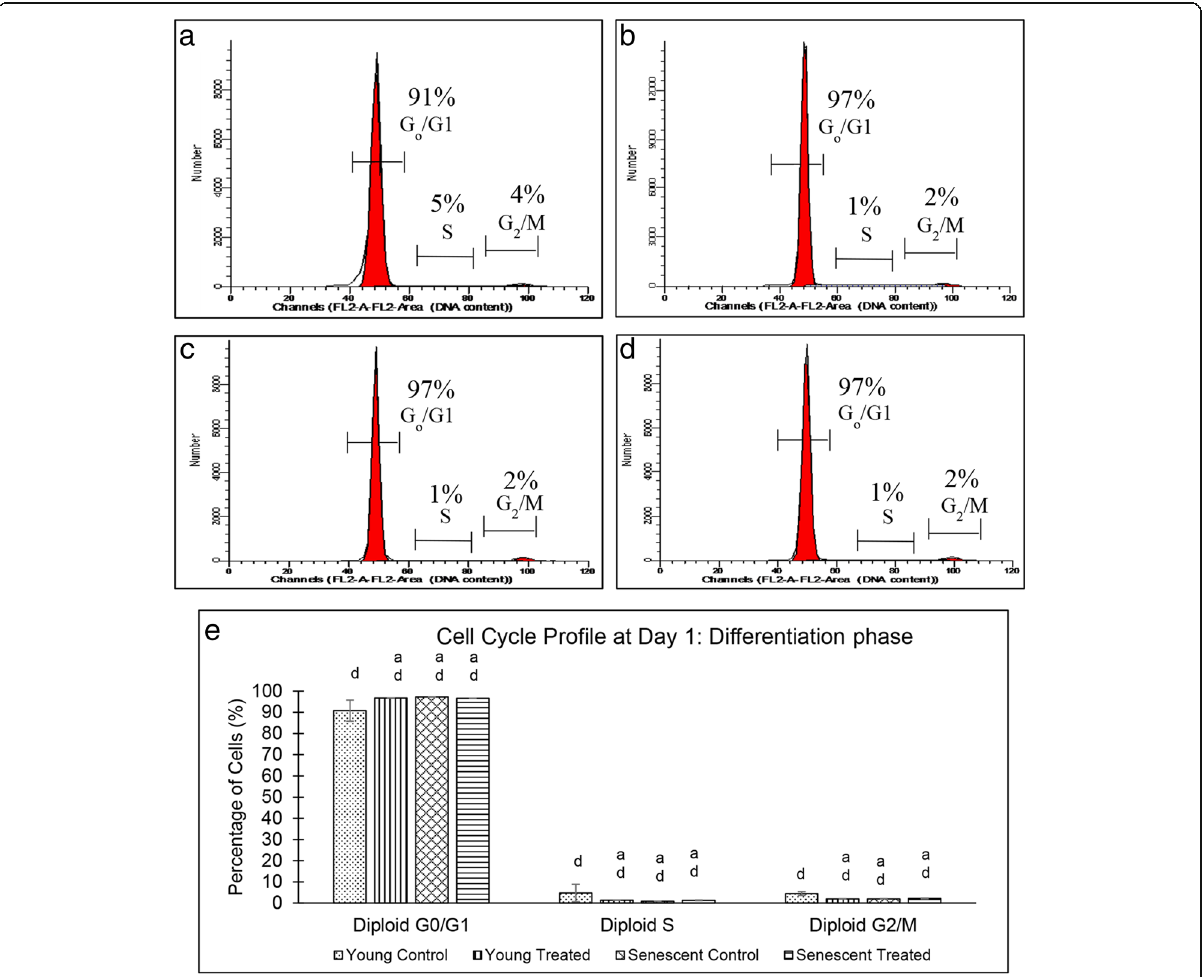
Fig. 7 Cell cycle profile of young and senescent myoblasts at day 1 of differentiation. Flow cytometry analysis of cell cycle progression of young control myoblasts ( a ), TRF-treated young myoblasts ( b ), senescent control myoblasts ( c ) and TRF-treated senescent myoblasts ( d ). Quantitative analysis of cell cycle progression of young and senescent myoblasts ( e ). a Denotes p < 0.05 compared to young control, and d p < 0.05 compared to same treatment at day 0 of differentiation. Data are expressed as mean ± SD ( n =